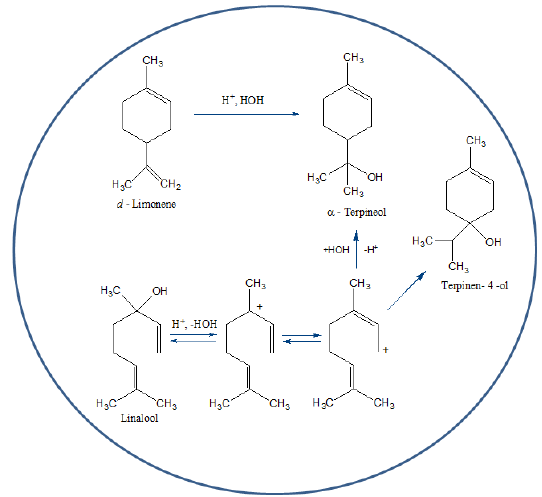
Figure 3. Molecular pathway from linalool and limonene to α -terpineol in the hydrodynamic cavitation microbubbles (adapted from Ref. [27]).